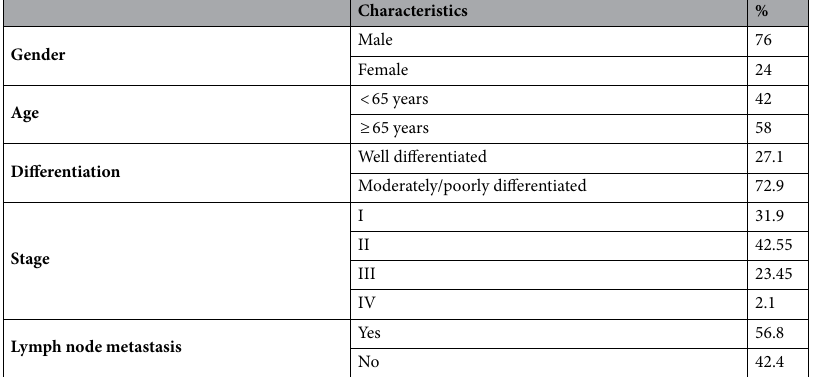
Table 2. Clinicopathological characteristics of gastric cancer patients.